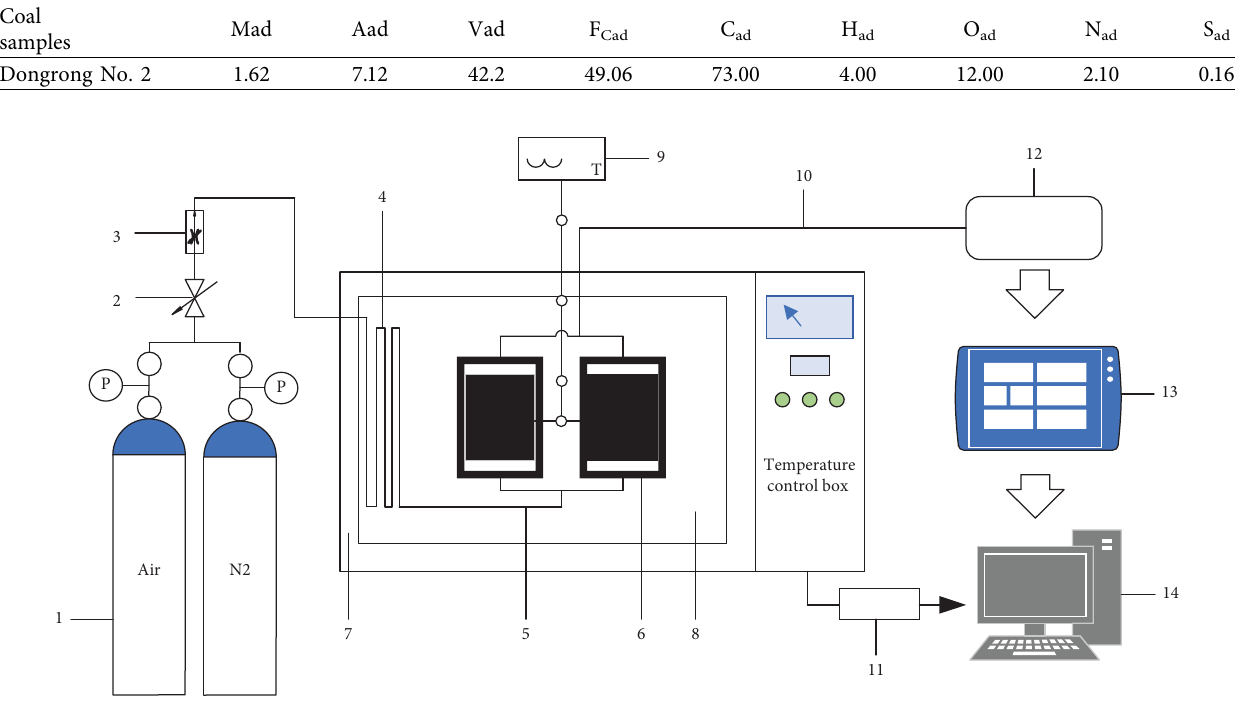
Figure 3: Temperature-programmed experimental device: 1-gas compression bottle; 2-pressure reducing valve; 3-fowmeter;4-gas pre- heating tube; 5-intake pipe; 6-reactor;7-thermal insulation layer; 8-coal sample oxidation chamber; 9-thermometer;10-exhaust pipe; 11- temperature acquisition system; 12-gas collector; 13-gas chromatograph; 14-computer. Table 2: Experimental conditions for heating coal